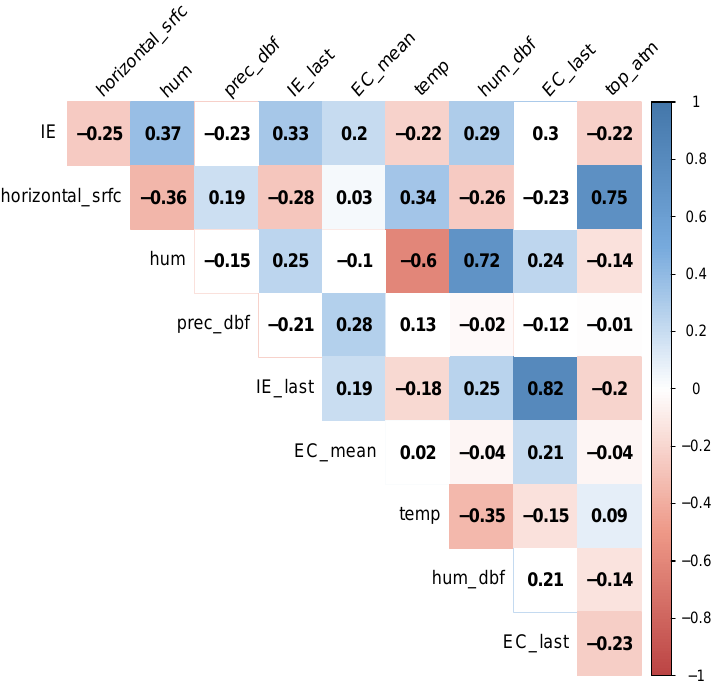
Figure 9. Correlation plot of parameters with strongest correlation with intestinal enterococci. Description of features is given in Table